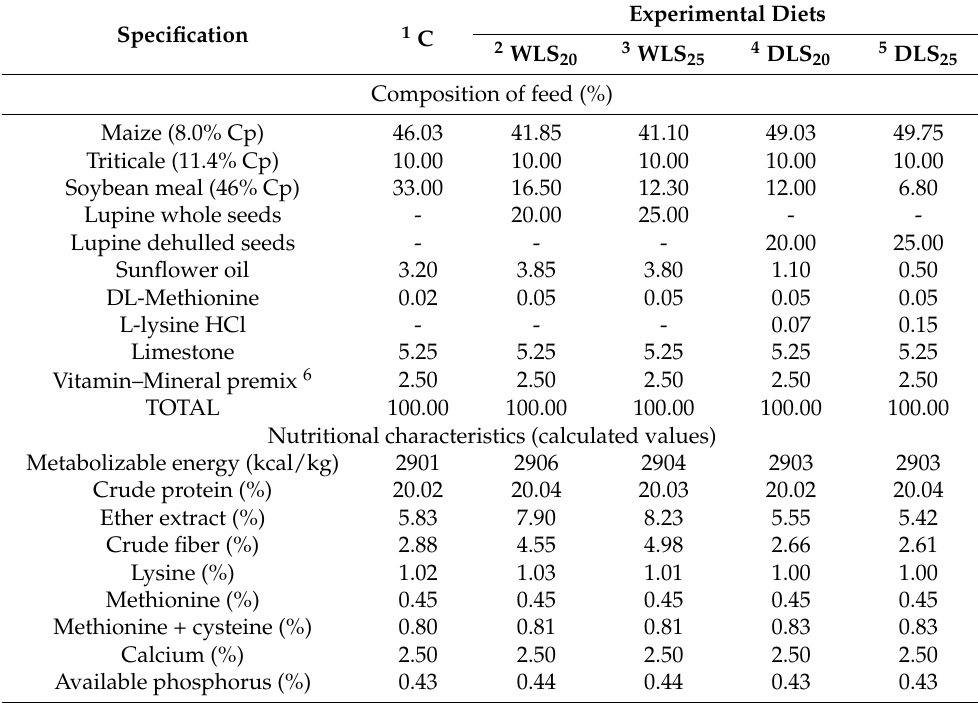
Table 1. Composition and nutritional characteristics of the diets used in the laying quails